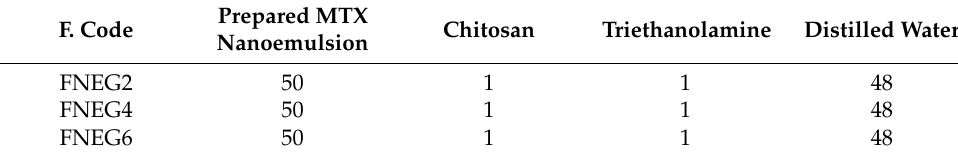
Table 9. Preparation of methotrexate-loaded nanoemulsion gel formulations ( w / w , %). F.